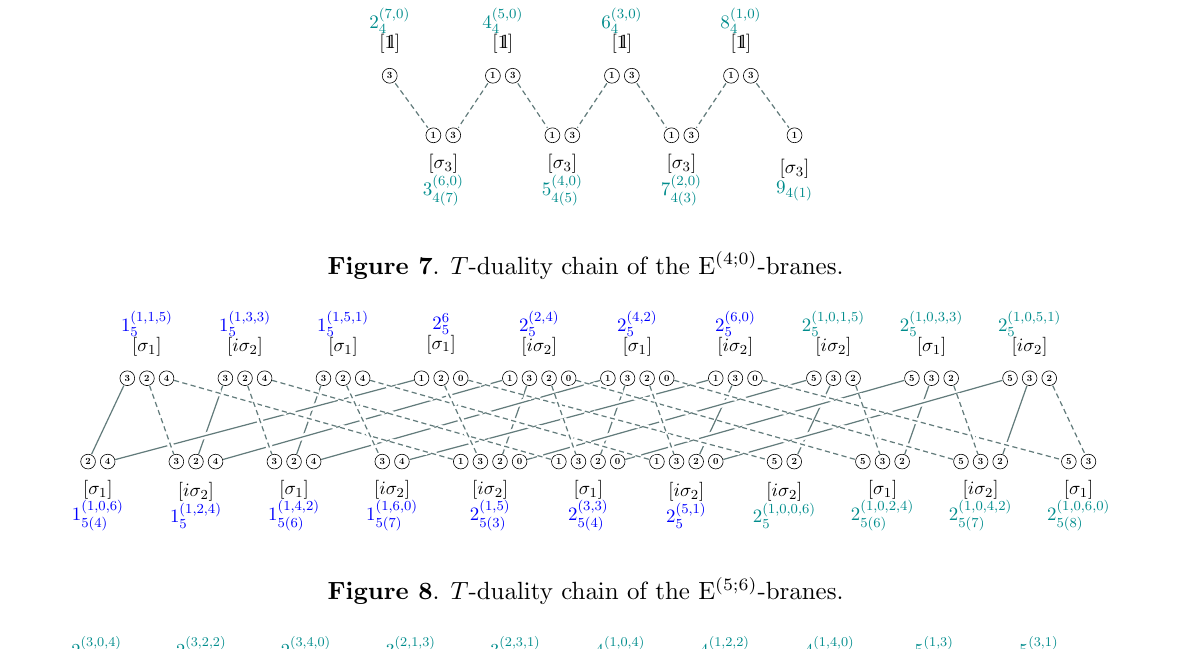
Figure 6 . T -duality chain of the E (4;3) -branes.